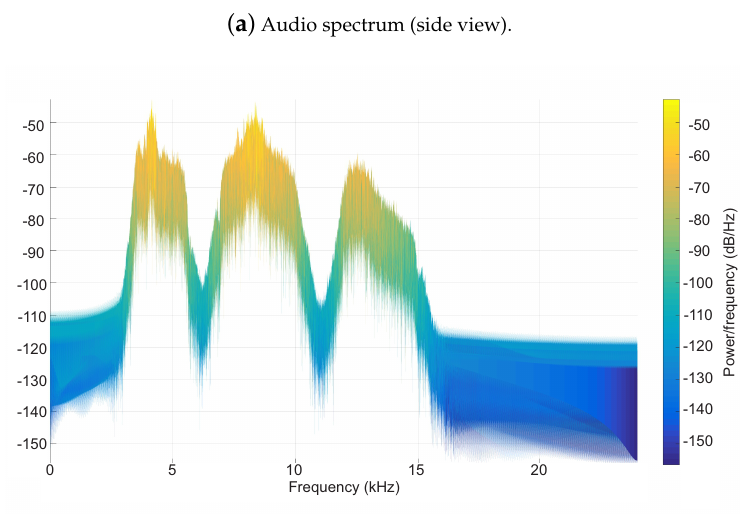
Table 1. Measured velocities and the C f value estimated with the Maximum Trace Method.